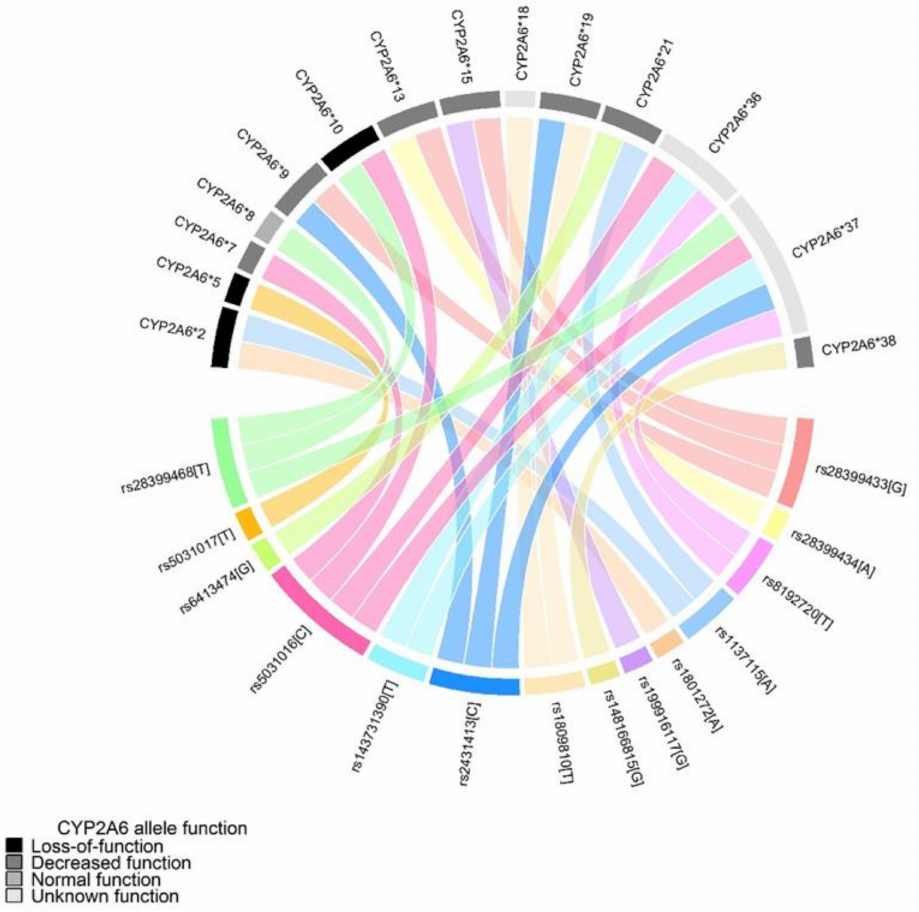
Figure 1. Circle plot for CYP2A6 alleles. SNPs assign CYP2A6 alleles and functions according to PharmVar